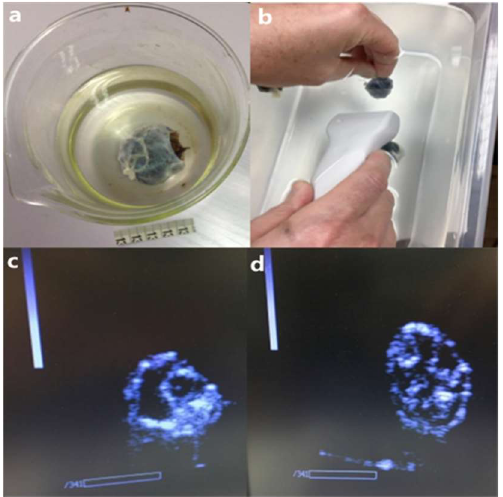
Figure 5. Ultrasonic examination of EndoXpand. ( a ) Intact black fungus covered by the outer mem- brane of casing. The corn silk ligature at one end had at this point degraded and broke. This released the black fungus pieces to the surrounding fluid. Since the individual pieces are of much smaller size, they will be able to pass the pylorus in humans without causing intestinal obstruction. ( b ) The testing environment for ultrasound experiments. ( c ) Ultrasound images of EndoXpand capsules with intact black fungus and granular black fungus ( d ).